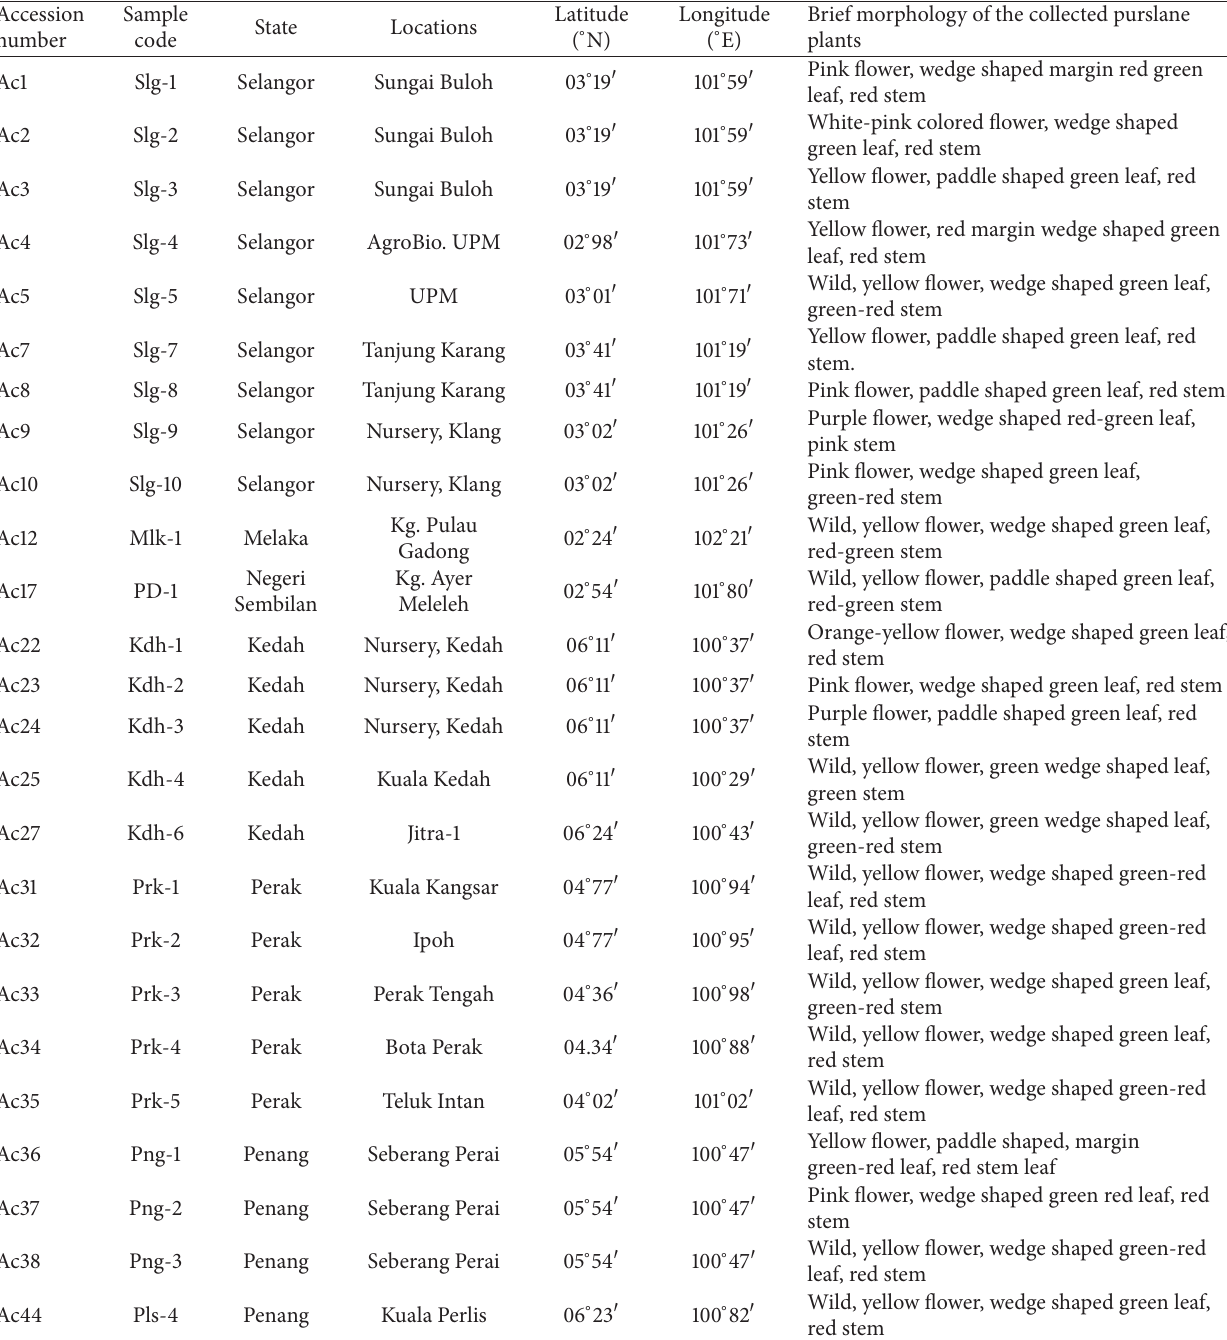
Table 1: Brief morphological descriptions and collection details of 25 selected purslane